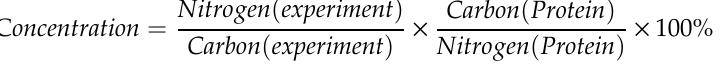
Figure 8. The XPS C1s spectra of the simulated fibronectin ( a ) and a comparison of the experimentally measured and calculated PCL-COOH-FN ( b ).